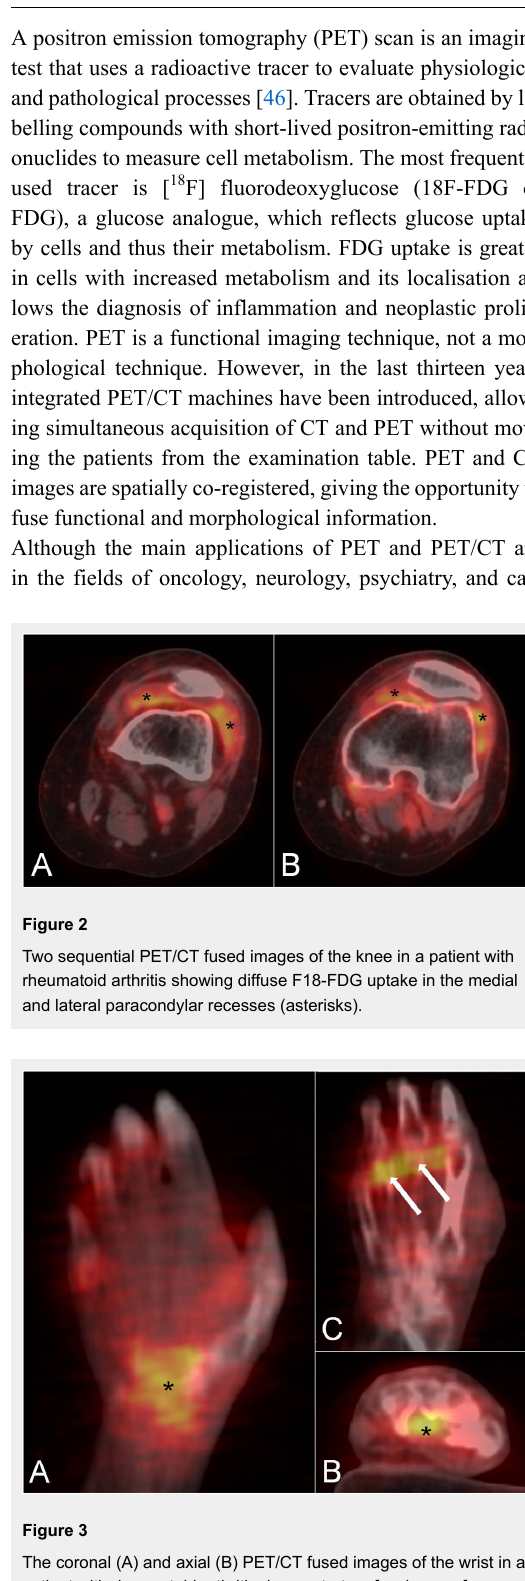
The coronal (A) and axial (B) PET/CT fused images of the wrist in a patient with rheumatoid arthritis demonstrate a focal area of F18-FDG uptake in the carpal tunnel, suggestive of flexor tendons tenosynovitis (asterisk). Tracer uptake is also observed in the metacarpophalangeal joints (C,